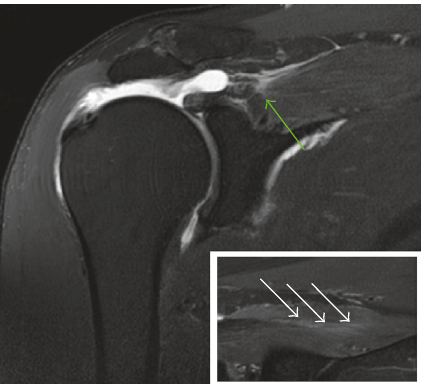
Figure 1: Coronal T2 weighted image with fat saturation of a right shoulder. A tear at the musculotendinous junction (green arrow) and a muscular edema (white arrows in the frame) are observed.